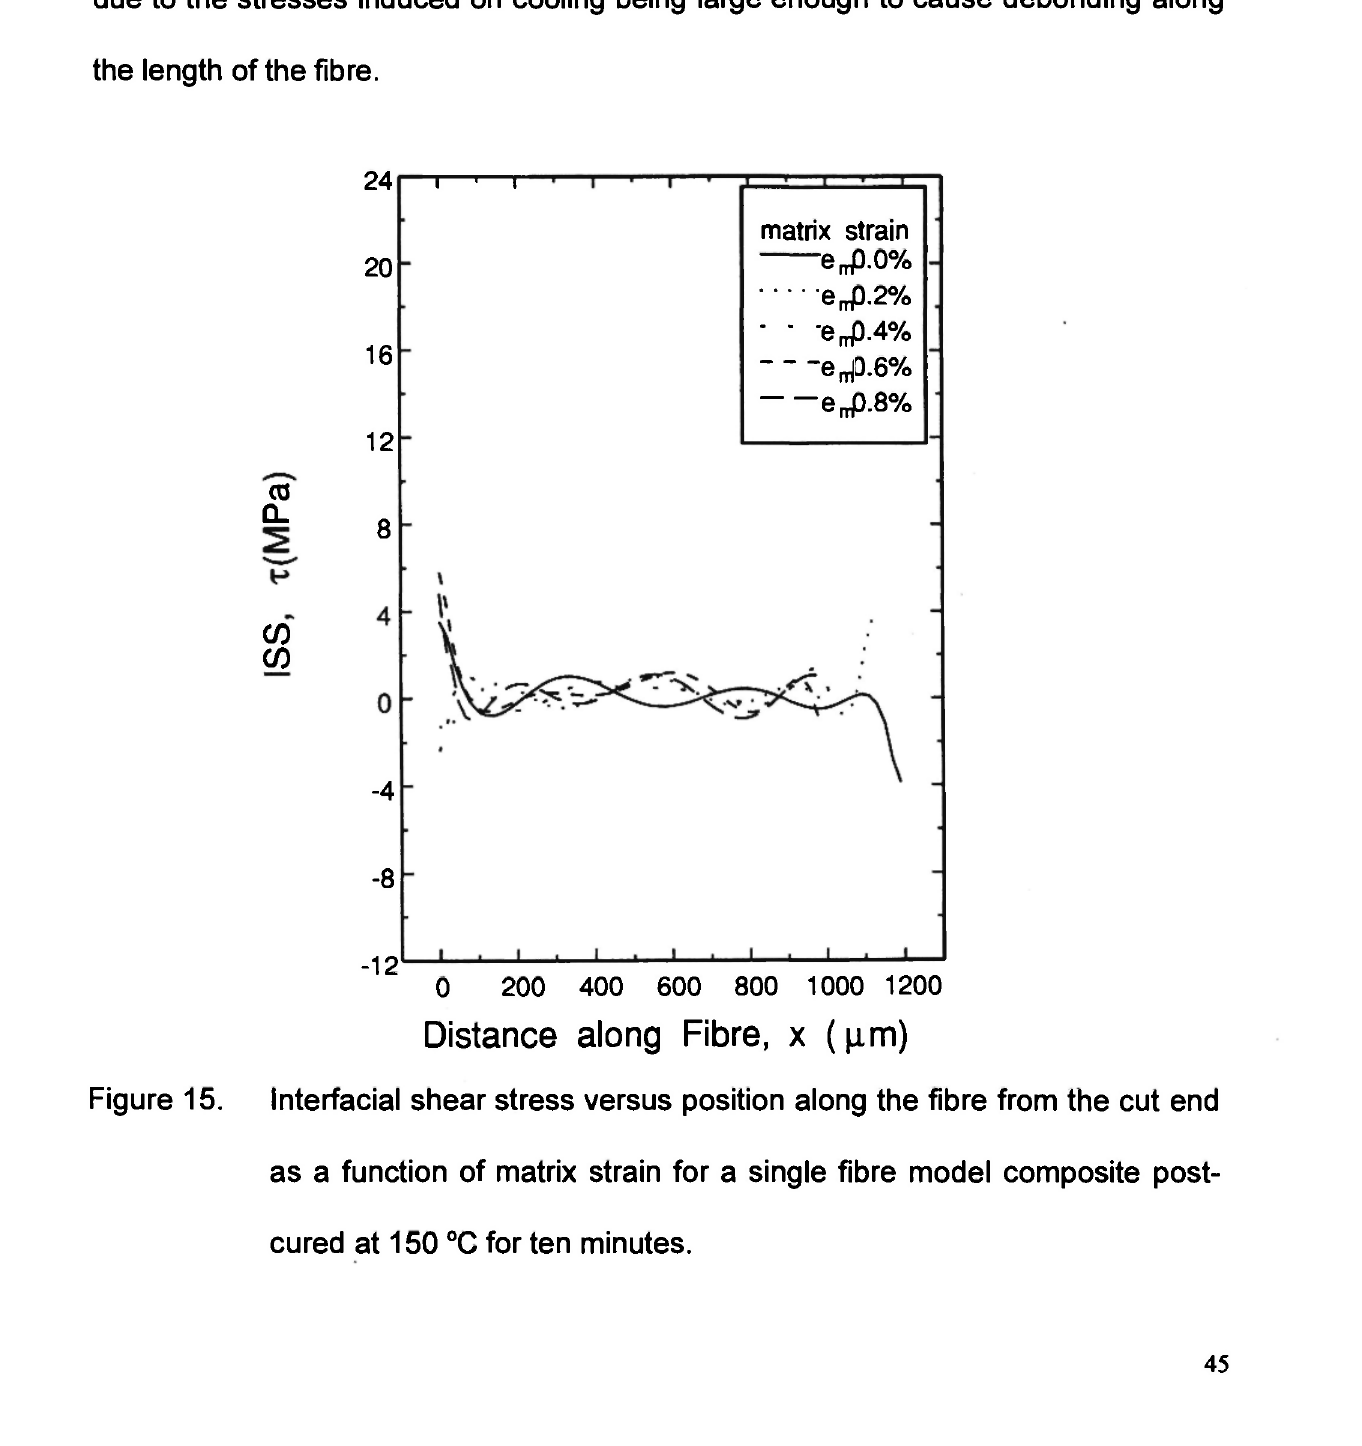
Figure 15. Interfacial shear stress versus position along the fibre from the cut end as a function of matrix strain for a single fibre model composite post- cured at 150 °C for ten